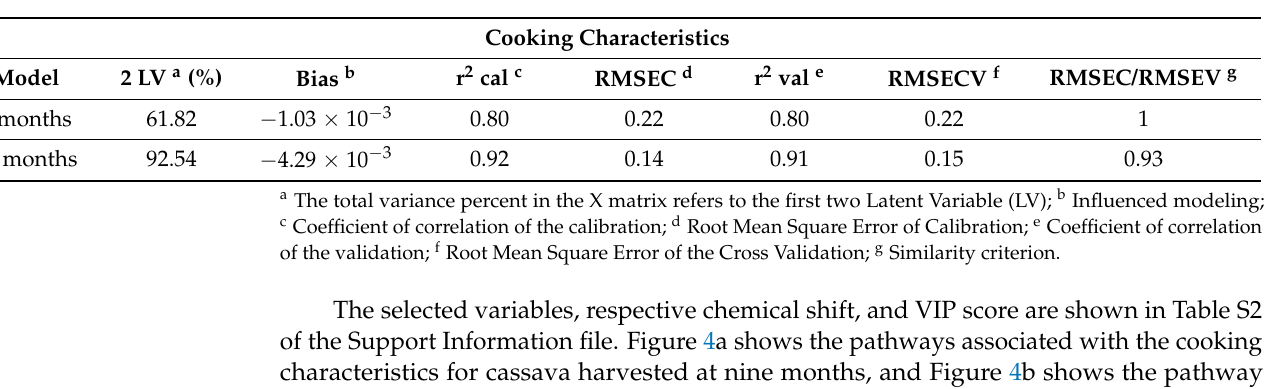
Table 1. Statistical parameters of the multivariate regression from OPLS-DA modeling of the cooking characteristics at 9 and 15 months.